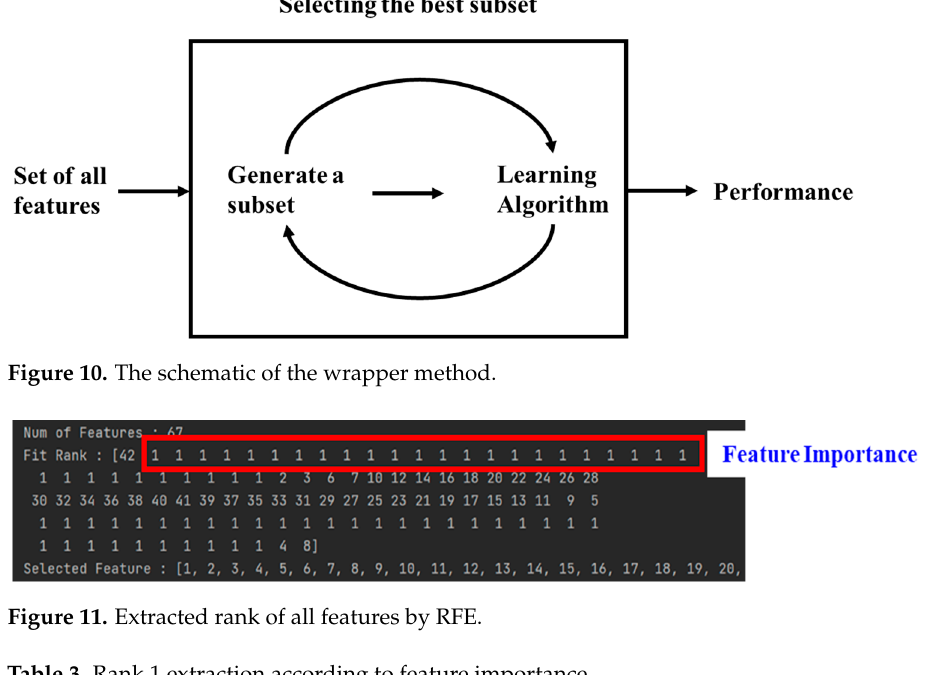
Figure 11. Extracted rank of all features by RFE. Table 3. Rank 1 extraction according to feature importance.